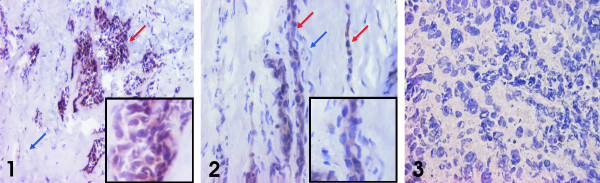
Asporin mRNA detection by chromogenic in situ hybridization. 1–2. Various magnifications (×100, ×400, ×400) of lobular carcinoma; red arrows, lobular tumor cells are positive; blue arrows, stromal cells are negative; 3. Ductal carcinoma is negative (×200).